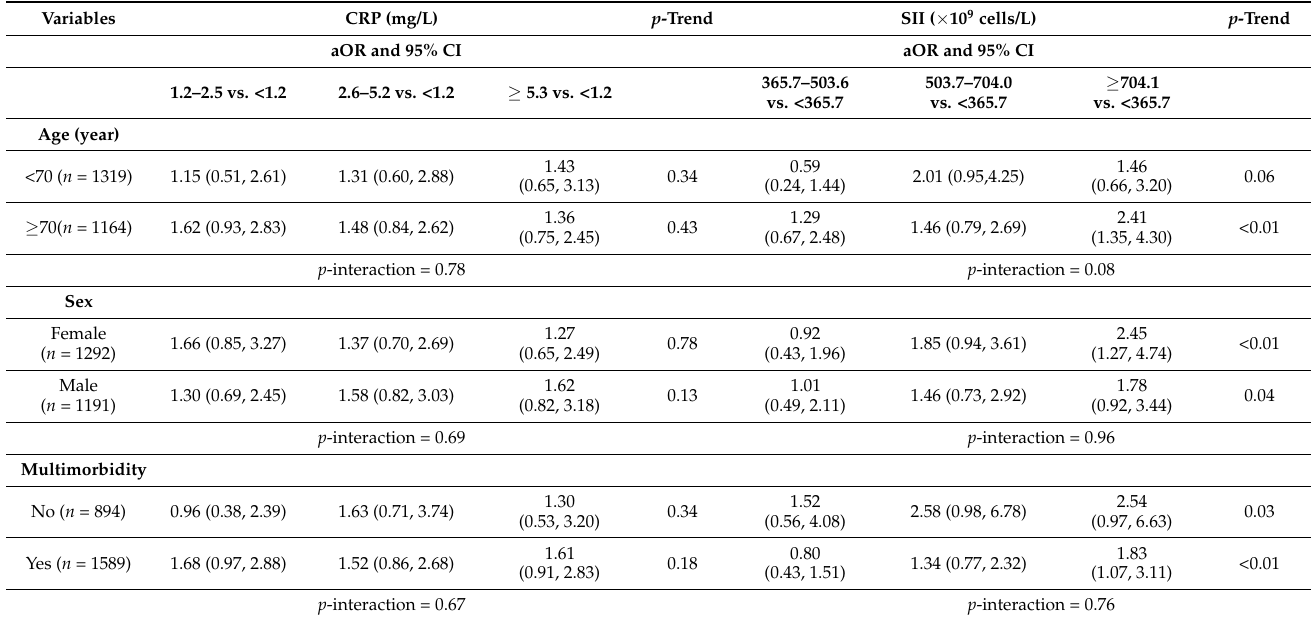
Table 5. Subgroup analysis for association between inflammatory biomarkers and sarcopenic obesity, NHANES 1999-2006 ( n =